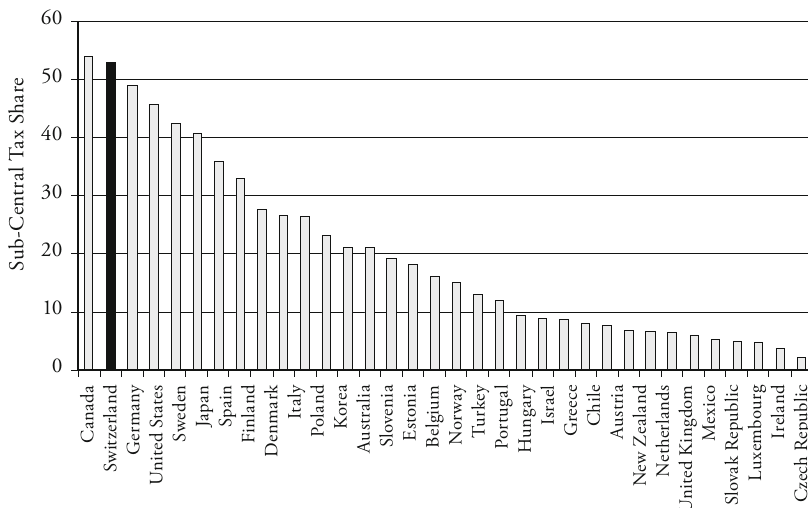
Figure 1: Tax decentralization across OECD countries in 2013. Tax revenue on state and local level as a share of general government tax